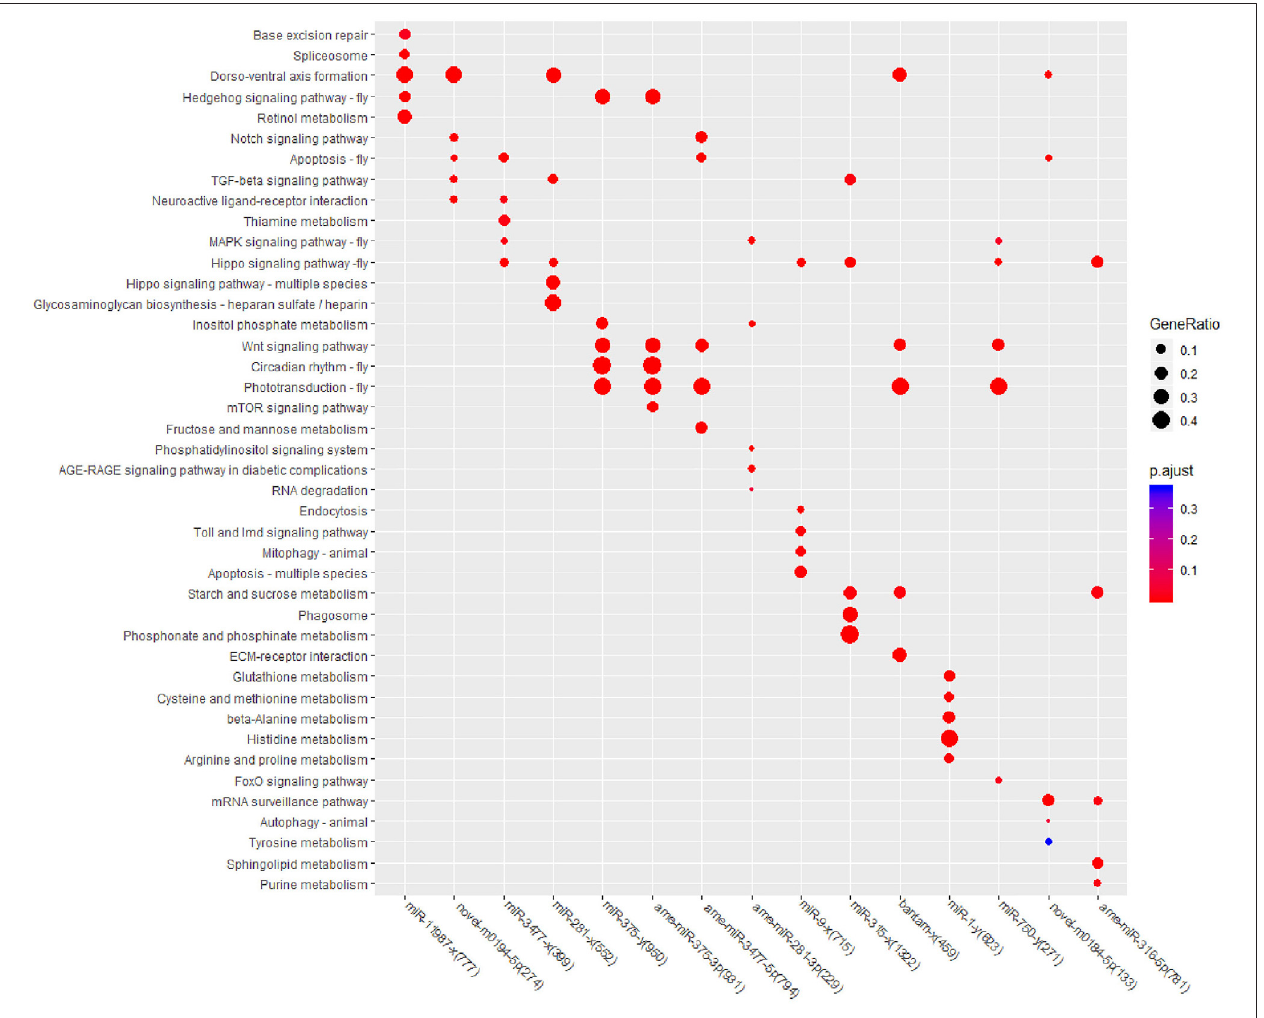
FIGURE 4 | KEGG enrichment for target genes of each